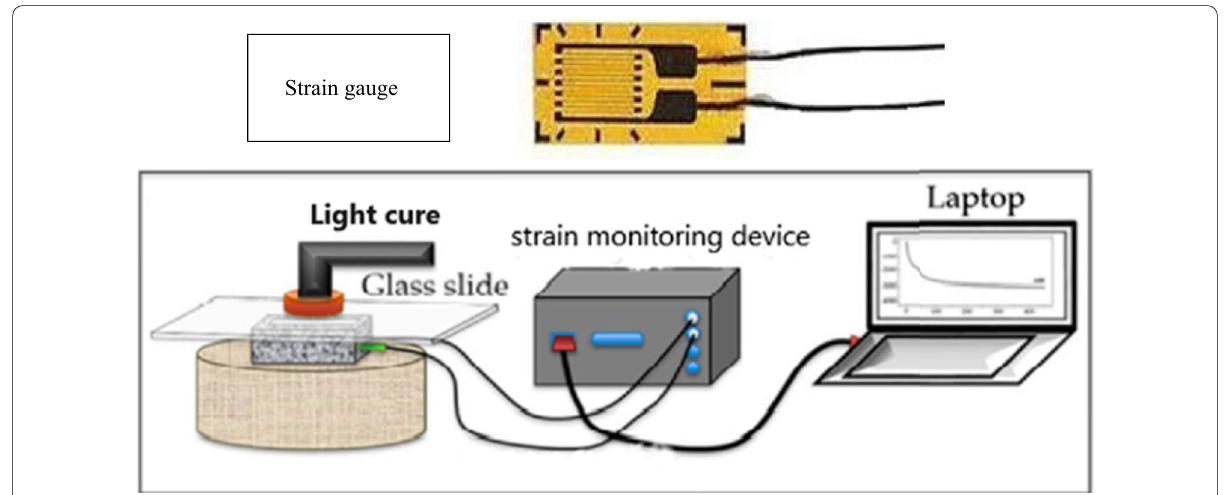
Fig. 1 Strain gauge connected to the strain-monitoring device